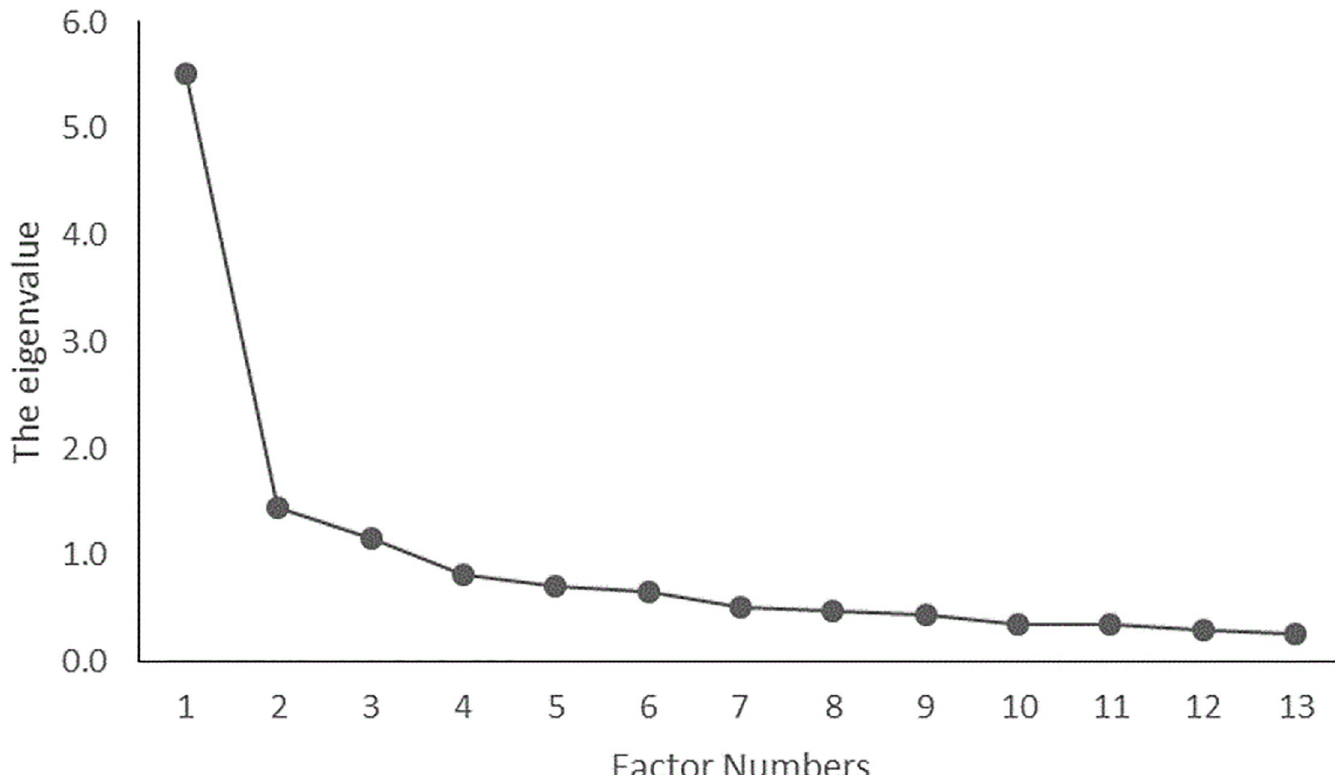
Fig 1. Factor decay rate related to improved self-efficacy among psychiatric